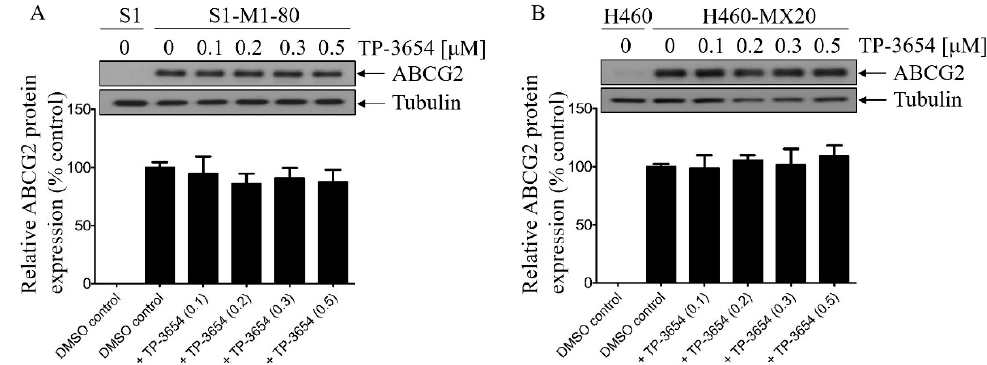
Figure 4. TP-3654 does not alter the protein expression of ABCG2 in ABCG2-overexpressing cancer cells. ( A ) S1-M1-80 and ( B ) H460-MX20 cancer cells were treated with DMSO (control) or increasing concentrations (0–0.5 μ M) of TP-3654 for 72 h and processed for Western blotting as described in Section 4. The representative immunoblots (upper panel) and the corresponding quantification (lower panel) of human ABCG2 protein are shown. α -Tubulin was used as an internal loading control. Data represent means ± S.D. from at least three independent experiments.